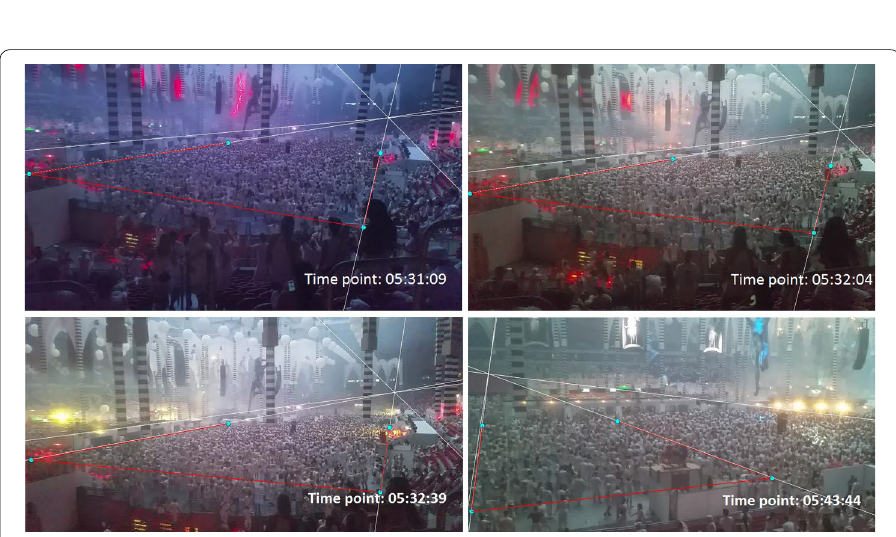
Fig. 15 Overview of video frames used for manually counting people (all time points are + 2:00 UTC at July 5, 2015). Videos and timestamps are courtesy of Jessey